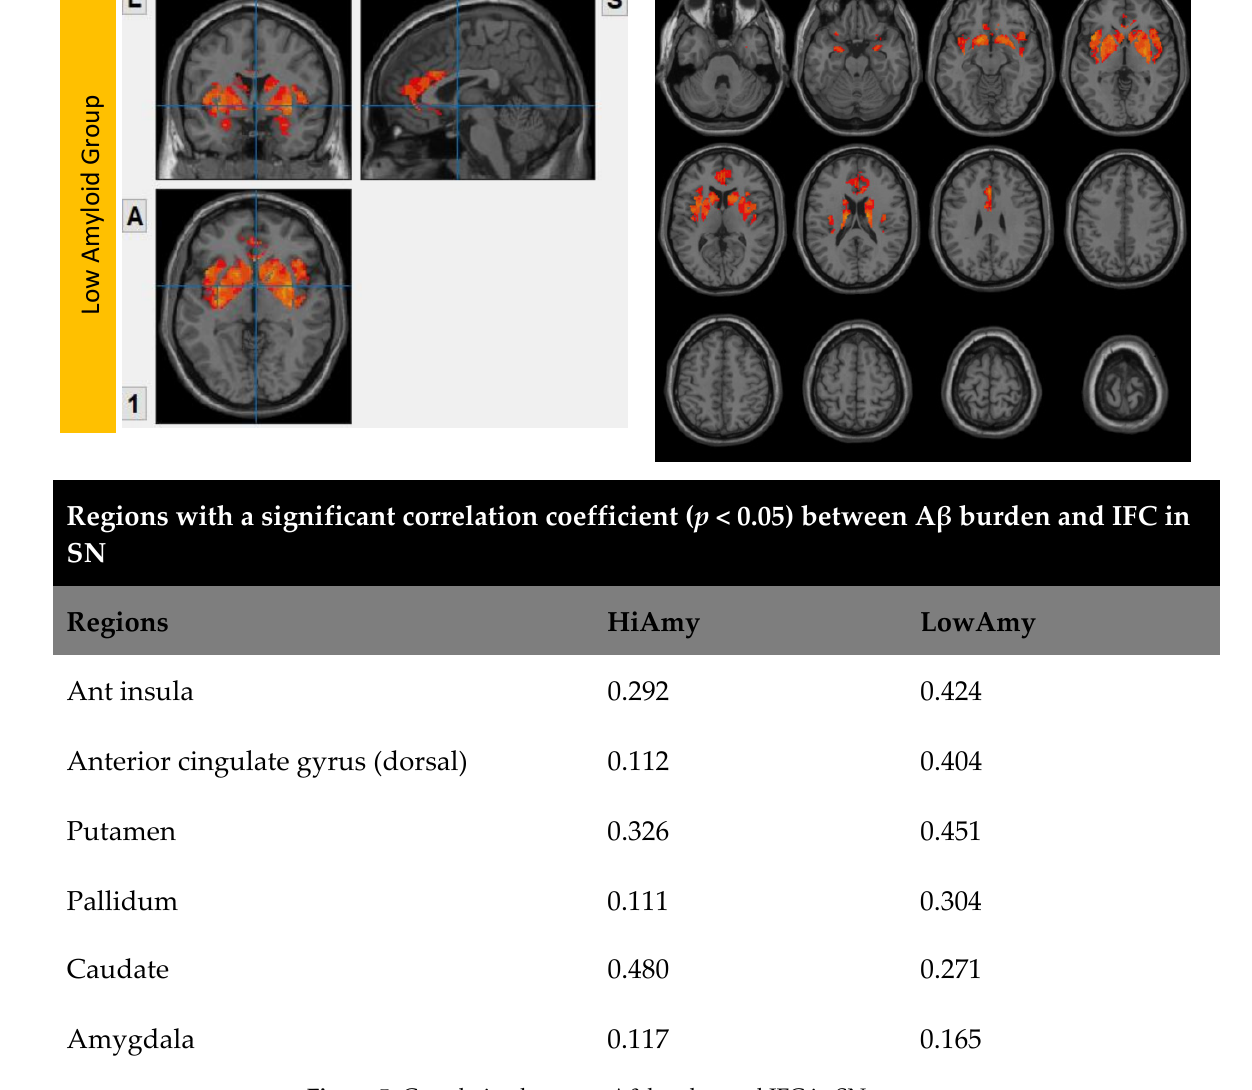
Figure 5. Correlation between A β burden and IFC in SN.